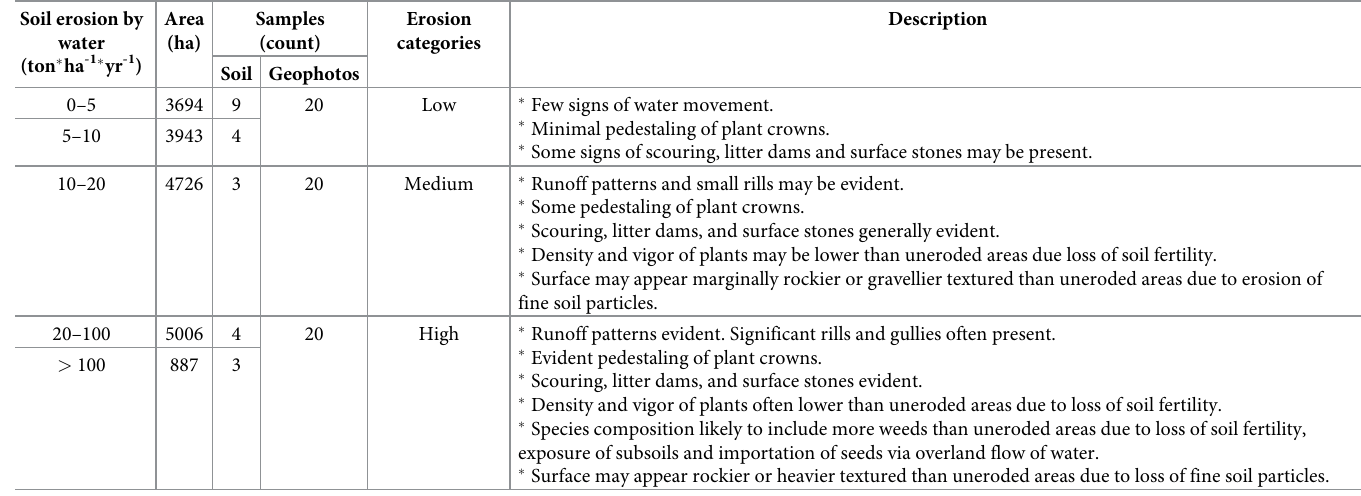
Table 3. Soil erosion categories used for visualization and field validation of RUSLE, after Warren et al. [88]. Soil erosion by